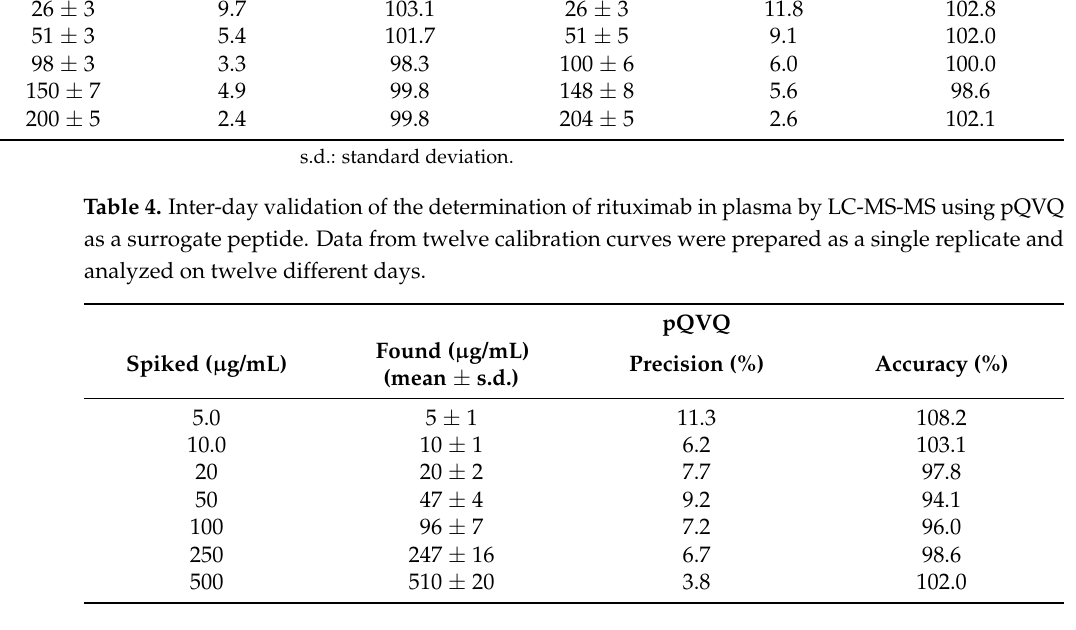
Table 3. Inter-day validation of the determination of rituximab in plasma by LC-MS/HRMS using either FSGS or pQVQ proteotypic peptides. Data from seven calibration curves were prepared as a single replicate and analyzed on seven different days. FSGS pQVQ Spiked ( µ g/mL)